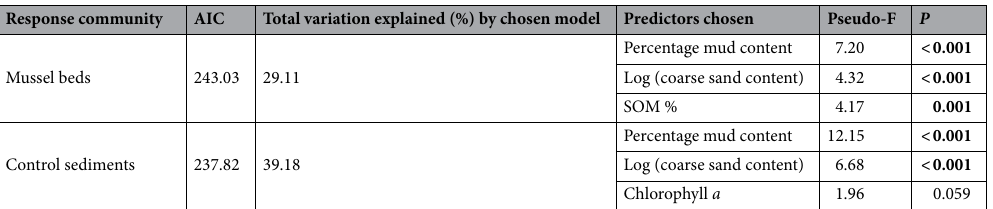
Table 4. Summary table of distance-based linear model (DISTLM) results, showing chosen environmental predictors best fit to corresponding response communities. Results shown are for models with lowest AIC values. Analyses based on Bray–Curtis similarity measures for square-root transformed macrofauna abundance data, constructed separately from mussel bed and control sediment cores. SOM sediment organic matter. Significant effects ( p < 0.05) are shown in bold.